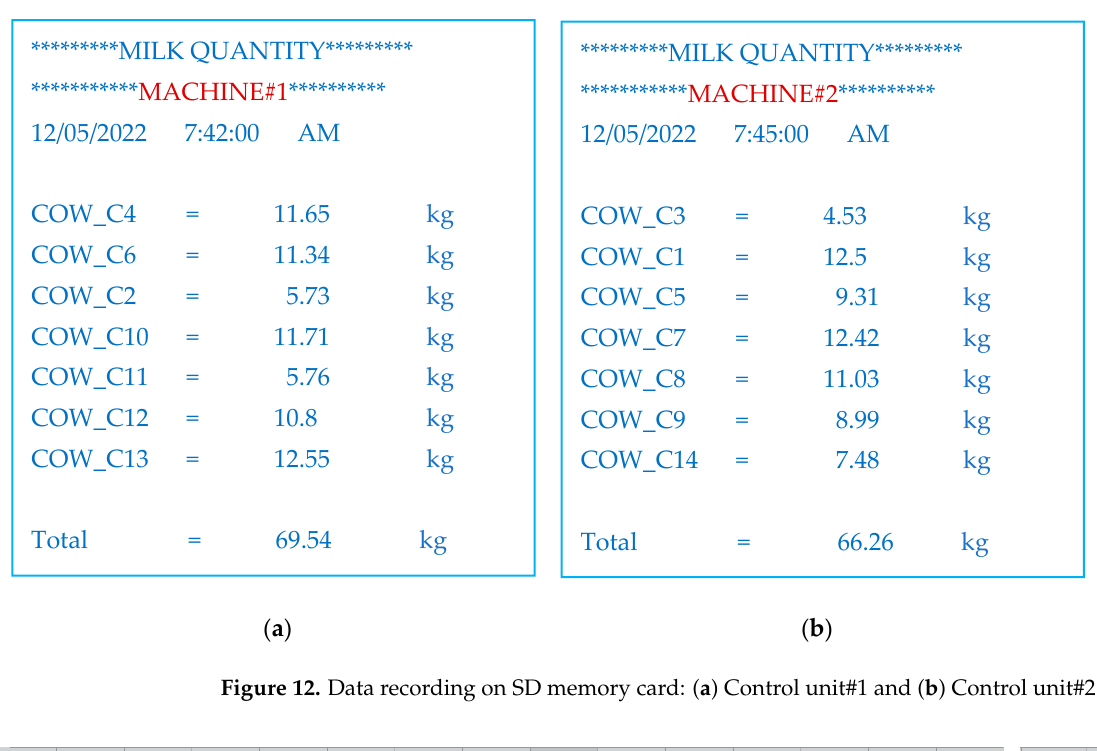
Figure 11. Real-time weight on LCD displaying ( a ) Control unit#2 and ( b ) Control unit#1. Agriculture 2022 , 12 , x FOR PEER REVIEW